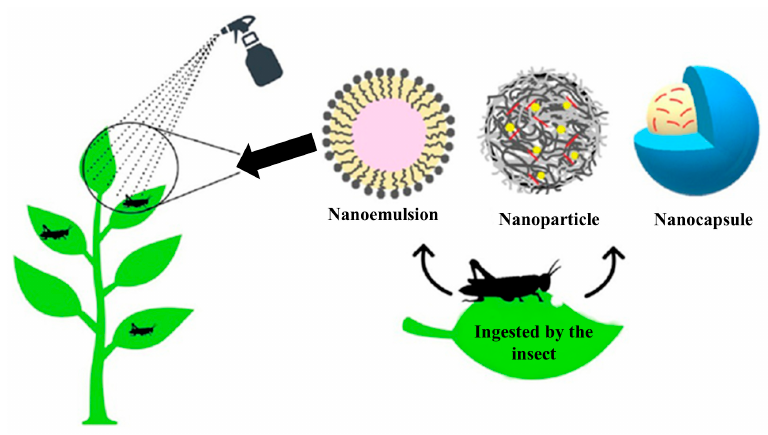
Figure 2. The most used nanosystems in insect pest control (adapted from Medina-Pérez et al. [45], with permission of Elsevier, 2019).